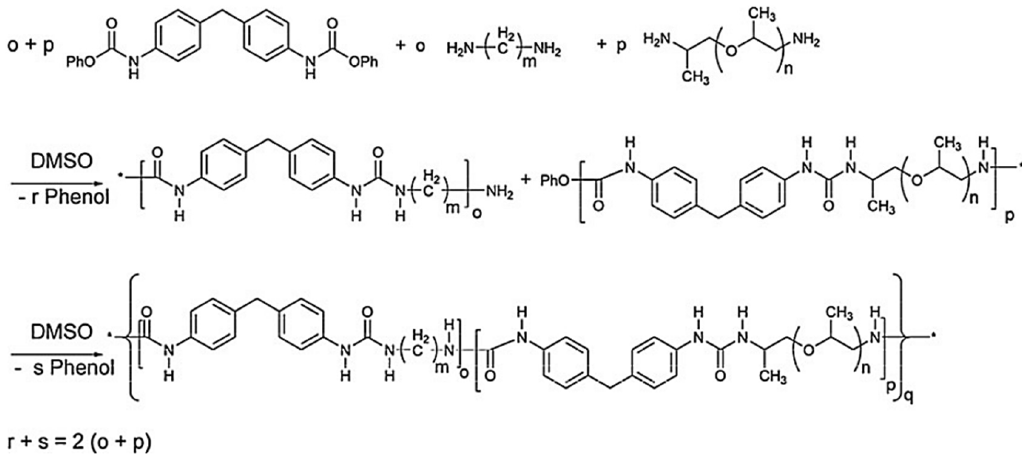
Figure 35. Polyurea elastomer synthesis from 4,4 ′ -DP-MDC in DMSO/80 ºC. From reference